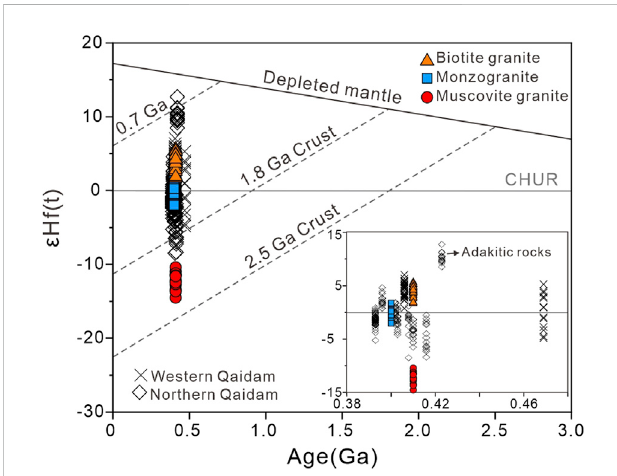
FIGURE 7 The plot of zircon ε Hf(t) values vs . U-Pb ages for investigated Huatugou granitoids, compared with published data of early Paleozoic granitoids in western and northern Qaidam (Song et al., 2014; Wu et al., 2014b; and Sun et al., 2020).